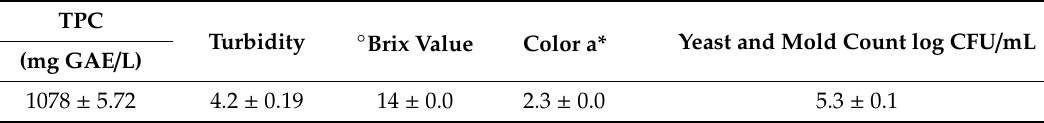
Table 1. Result for total phenolic content (TPC), turbidity, ◦ Brix, color a*, and yeast and mold count of unprocessed pomegranate